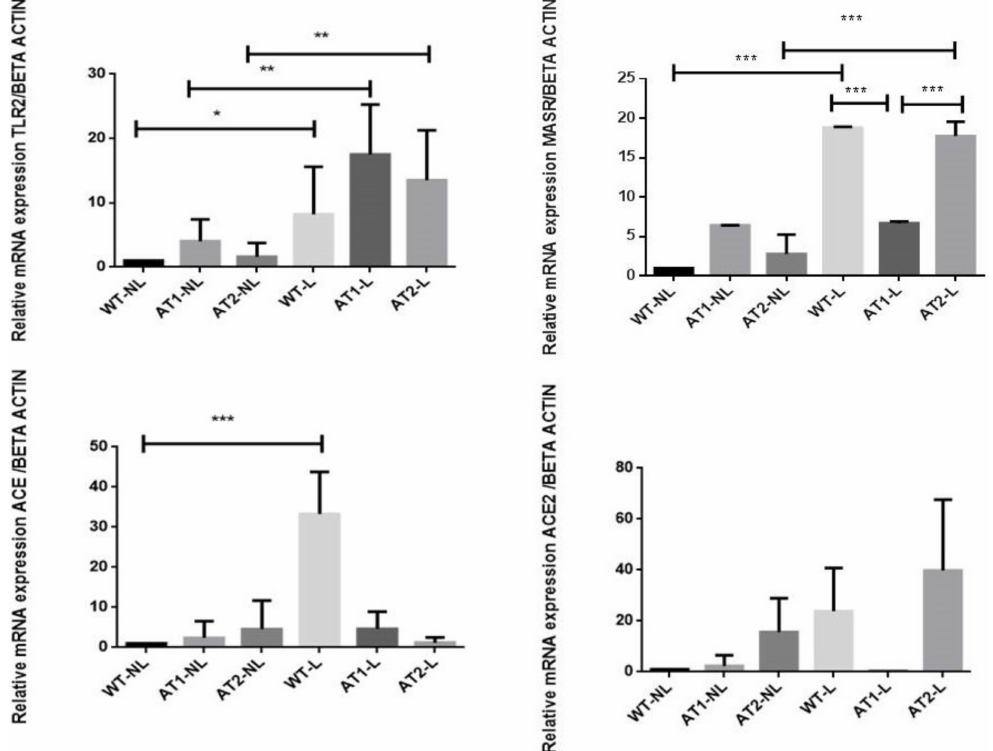
Figure 3. Relative mRNA expression results for TLR2, MasR, ACE and ACE2 for the non-ligature and ligature groups of the three knockout mouse strains. All graphs show mean ± SE. (standard deviation). Statistical differences by brackets labeled by * p < 0.05, ** p < 0.01, *** p < 0.001, comparing WT-NL vs. WT-L, AT1-NL vs. AT1-L, AT2-NL vs. AT2-L, WT-L vs. AT1-L, AT1-L vs. AT2-L. (Graph Pad Prism 6.01 software). n = 5 animal per